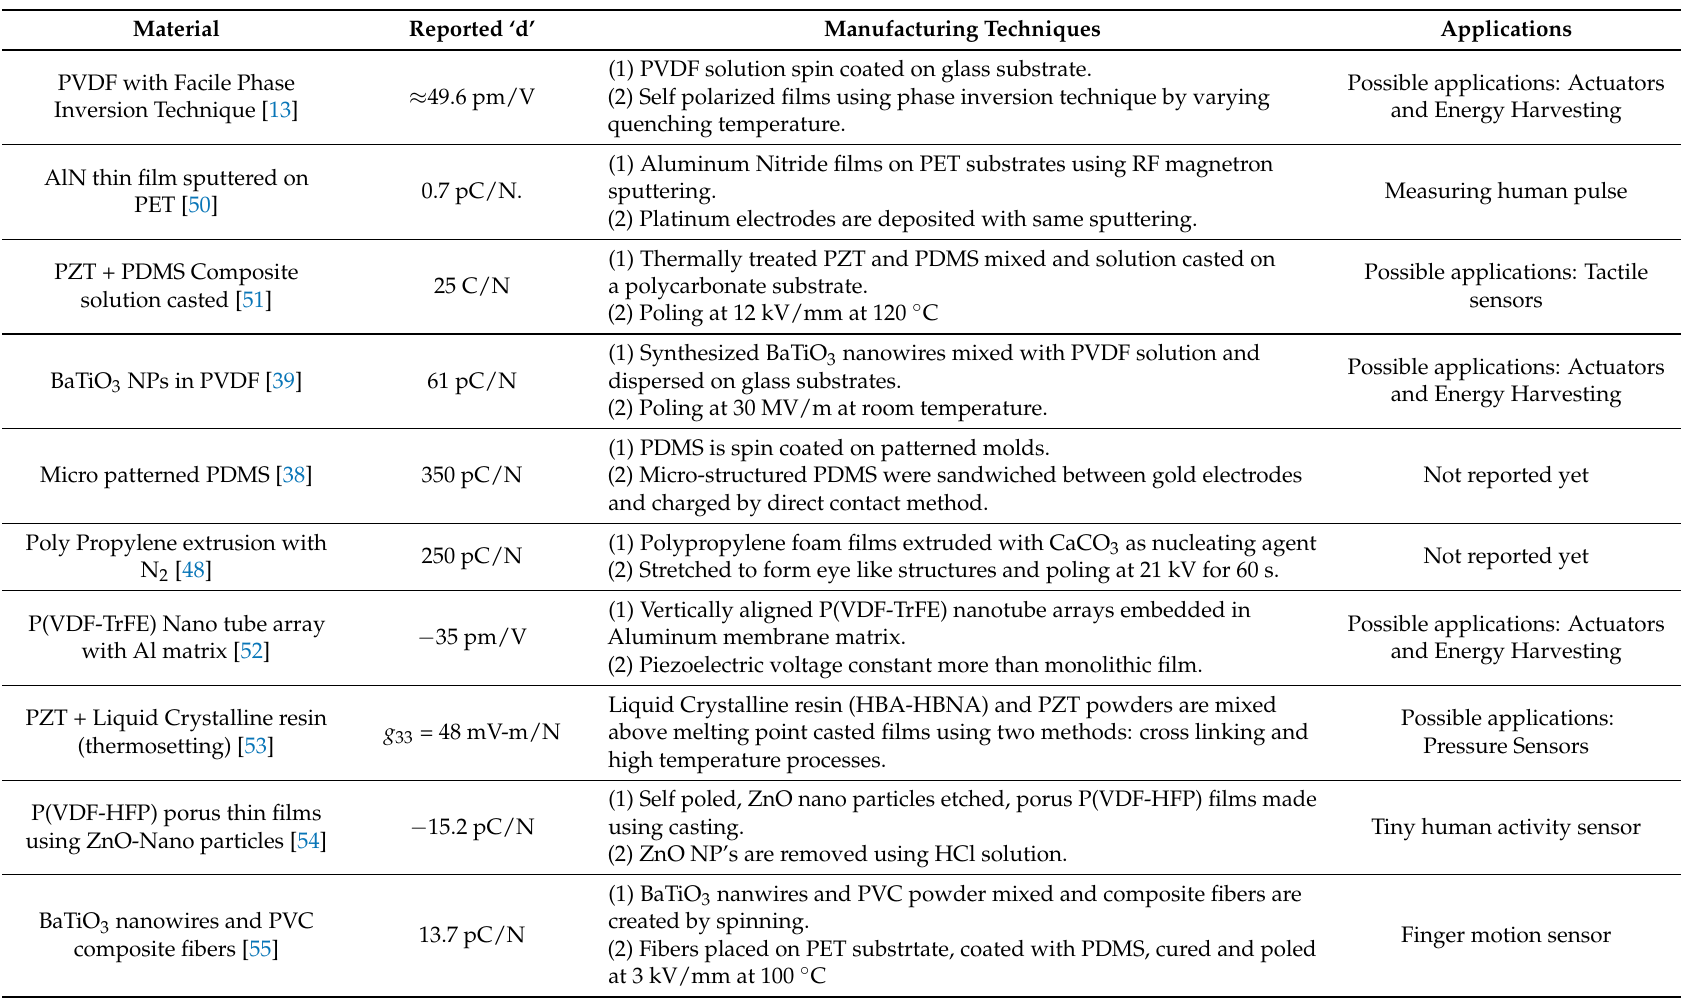
Table 3. Recent reportings on piezoelectric